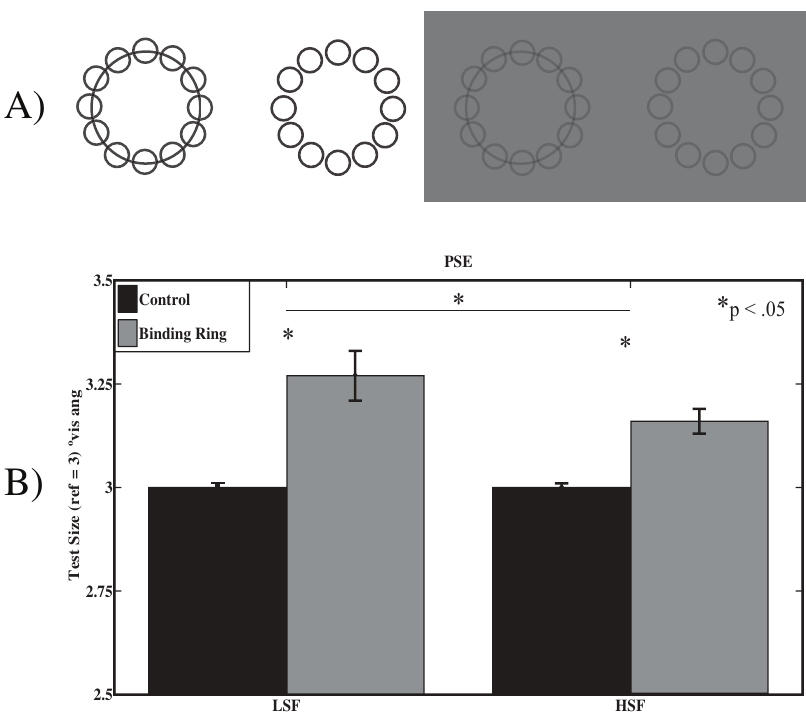
Figure 6. Spatial frequency manipulations. A ) Low- (top left) and high-pass (top right) versions of the binding ring stimuli. B ) Results of experiment 3. The points of subjective equality (PSE) of both high (HSF) and low spatial frequency (LSF) conditions are plotted for both the control and binding ring conditions. Error bars represent standard error of the mean. Asterisks indicate significance at p <